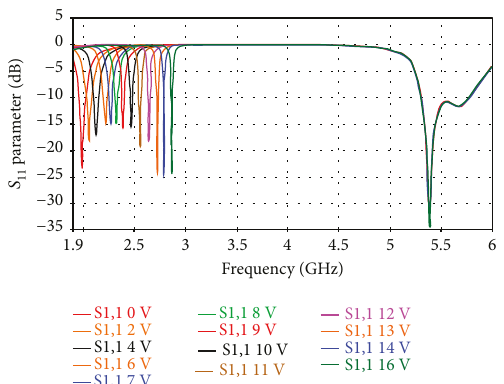
Figure 13: S 11 parameter of the antenna using the varactor equivalent